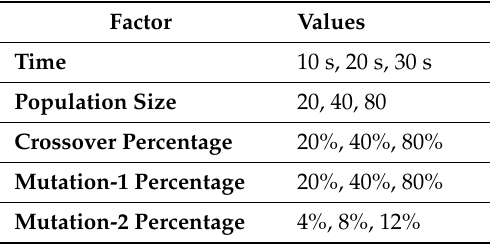
Table A1. DoE parameter